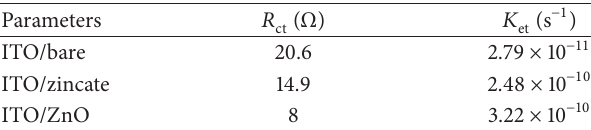
Table 1: EIS parameters for ZnO nanoparticles.